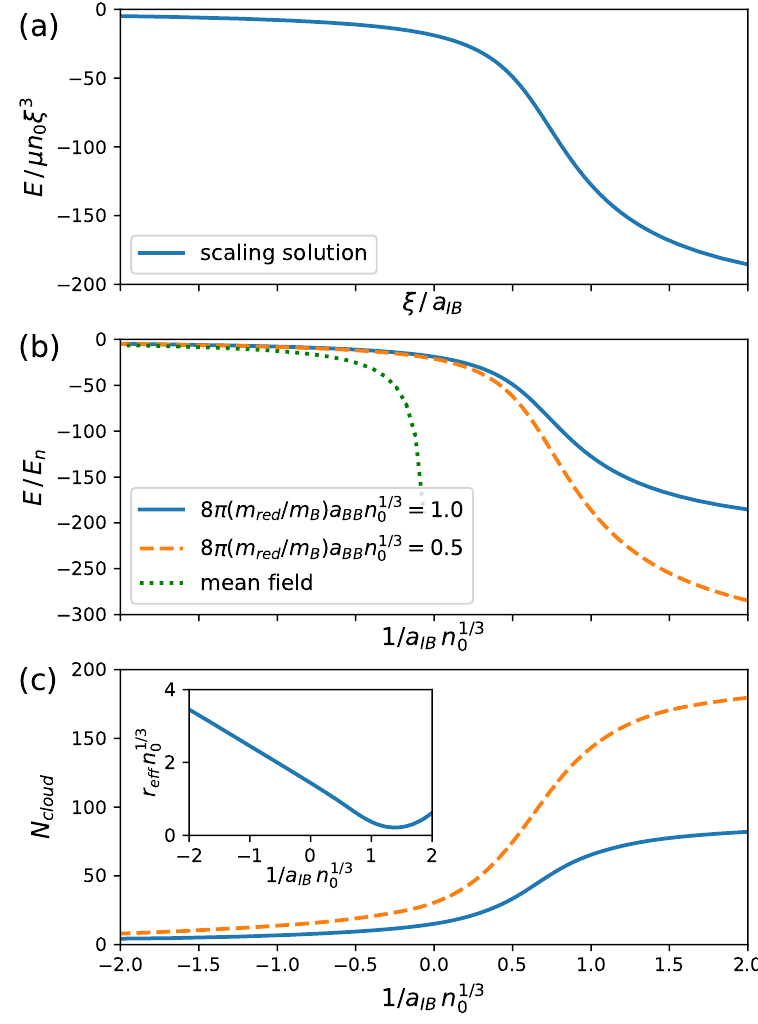
Figure 3: Bose polaron energy across an impurity-boson Feshbach resonance. (a) ξ 3 as function of the impurity-Bose Scaling solution for the polaron energy E /µ n 0 interaction ξ/ a for a Gaussian potential of fixed range R = ξ . (b) Polaron energy E IB = ħ h 2 n 2 / 3 / 2 m in density units E in dependence on the impurity-Bose interaction n red 0 / 3 n 1 1 / a for different BEC gas parameters. The polaron binding energy is larger IB 0 / 3 / m ) a = 0.5 (orange dashed) compared n 1 for weak boson repulsion 8 π ( m red B BB 0 / 3 / m ) a = 1.0 (blue solid); at weak coupling it n 1 to stronger repulsion 8 π ( m red B BB 0 approaches the mean-field result (13) (green dotted). (c) Particle number N cloud within the polaron dressing cloud. Inset: the effective range r for fixed potential eff / 3 = 1 is smallest on the repulsive range Rn 1 0